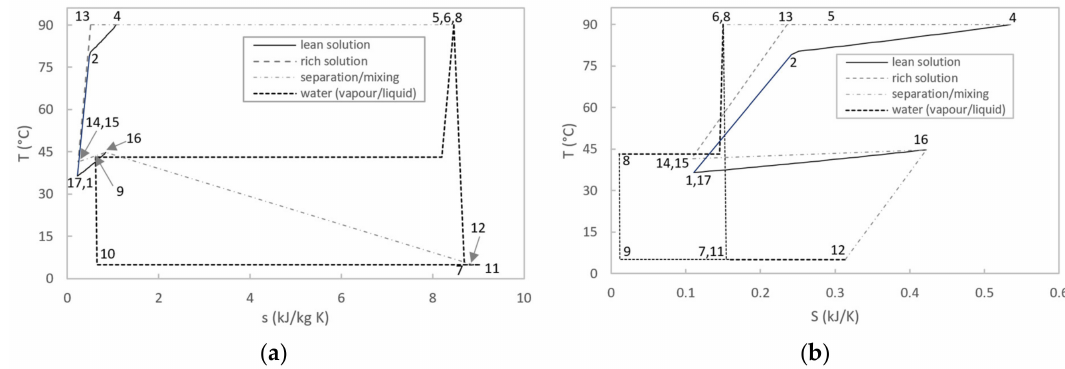
Figure 4. Temperature entropy diagrams of the combined cycle for the baseline conditions for specific entropy ( a ) and absolute entropy ( b ) of the working